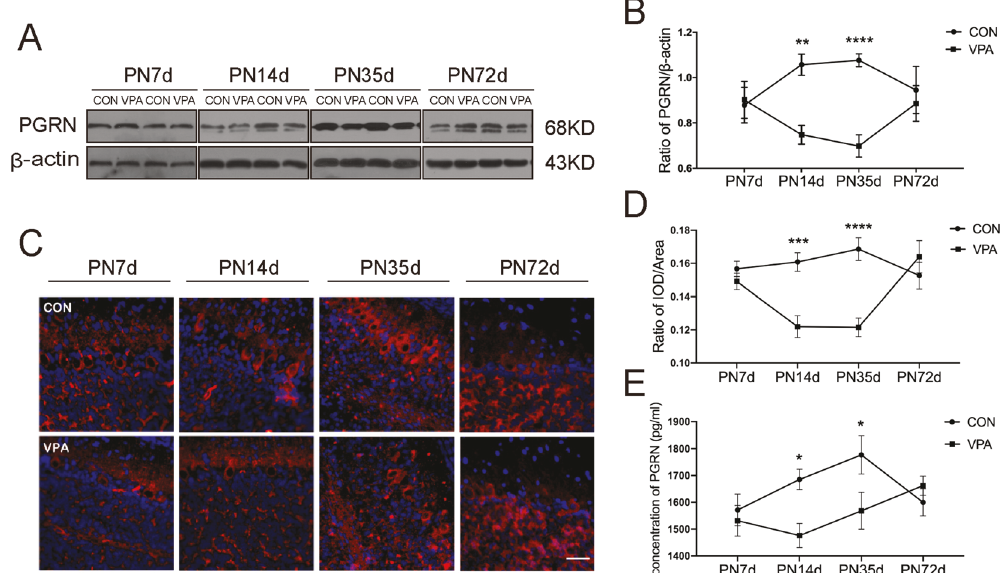
Fig. 1 Prenatal exposure to VPA caused the alterations of PGRN temporal expression in the cerebellum. Representative blots ( A ) and quanti fi cation ( B ) showed the expression of PGRN at four different time points. Representative images (bar = 100 μ m) ( C ) and quanti fi cation ( D ) of immuno fl uorescence staining described that the expression of PGRN is in the same trend as Western blotting. E PGRN ELISA protein quantitation of cerebellar tissue. Data are expressed as mean ± SEM. Two-way ANOVA followed by Sidak post hoc. (* P < 0.05, ** P < 0.01, *** P < 0.001, **** P < 0.0001, sample sizes ( n ): n = 5/group for Western blotting and immuno fl uorescence staining. n = 4/group for